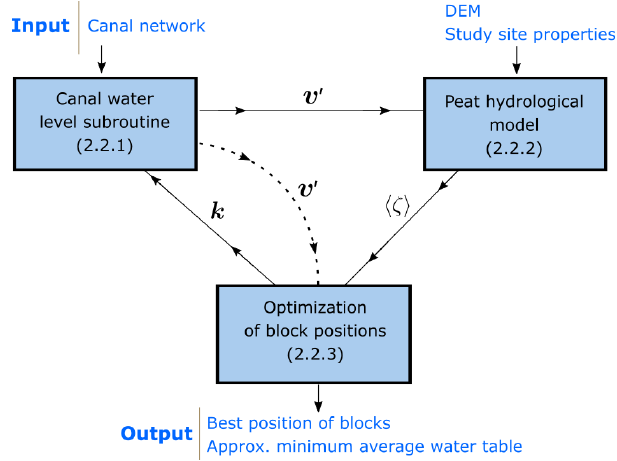
Figure 3. Schematic representation of a single iteration of the com- putation showing the most relevant input and output and the inter- action between the modules. The numbers in parentheses refer to the corresponding section in the main text. DEM stands for digital elevation model. The optimization algorithm proposes a particular position for the canal blocks, k . Then, the canal water level sub- routine computes the canal water level (CWL) resulting from that block placement, v (cid:48) . This information is passed on to the peat hy- drological model, which solves for the WTD with v (cid:48) as boundary conditions and computes the resulting target variable, which is the average WTD over 3 dry days, (cid:104) ζ (cid:105) , defined in Sect. 2.2.2. The op- timization algorithm evaluates the performance and proposes a new k according to some rules specific to each algorithm. When using the alternative simple optimization strategy (SO), the CWL change, which depends only on v and v (cid:48) (see Eq. 13), is used as a target vari- able. This corresponds to the shortcut shown by the dashed arrows.